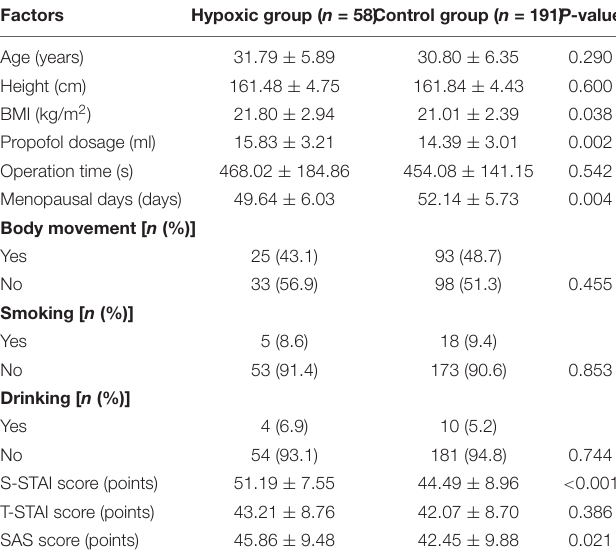
TABLE 1 | Single factor analysis of influencing factors of hypoxia in patients undergoing painless abortion. Factors